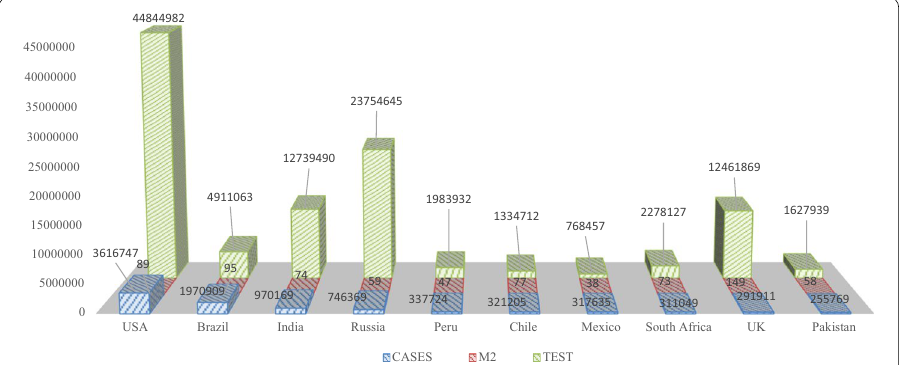
Fig. 1 COVID-19 infected cases, financial development, and testing scores. Source : Worldometer (2020,